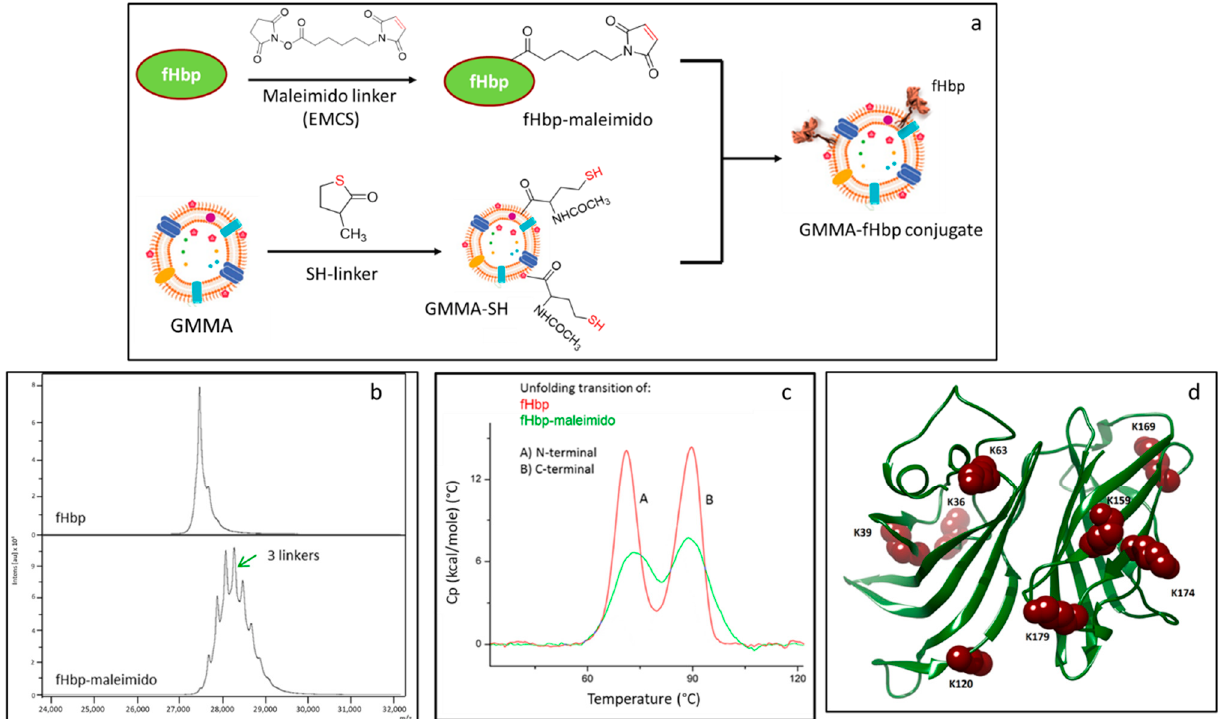
Figure 1. ( a ) Conjugation scheme for random linkage of fHbp to GMMA: fHbp was derivatized with EMCS linker followed by chemical conjugation to GMMA functionalized with SH linker; ( b ) MALDI-MS analysis of fHbp-maleimido compared to starting fHbp; ( c ) DSC analysis of fHbp-maleimido compared to starting fHbp; ( d ) fHbp structure highlighting lysine residues involved in the derivatization with EMCS linker as identified by peptide mapping analysis.